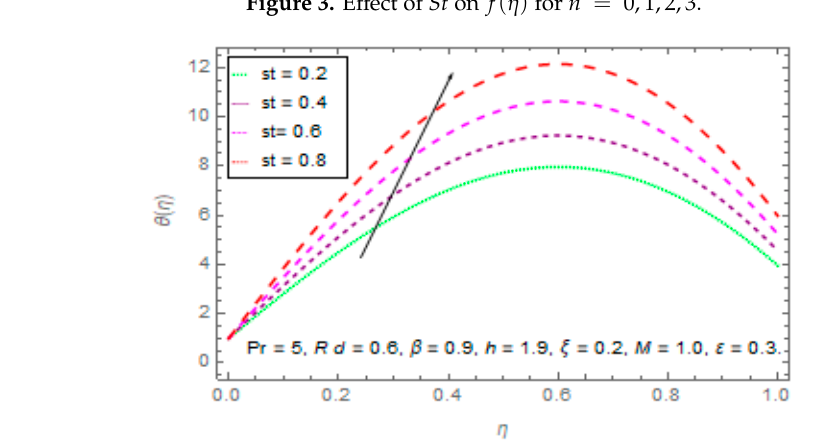
Figure 3. Effect of 𝑆𝑡 on 𝑓(𝜂) for 𝑛 = 0,1,2,3 .